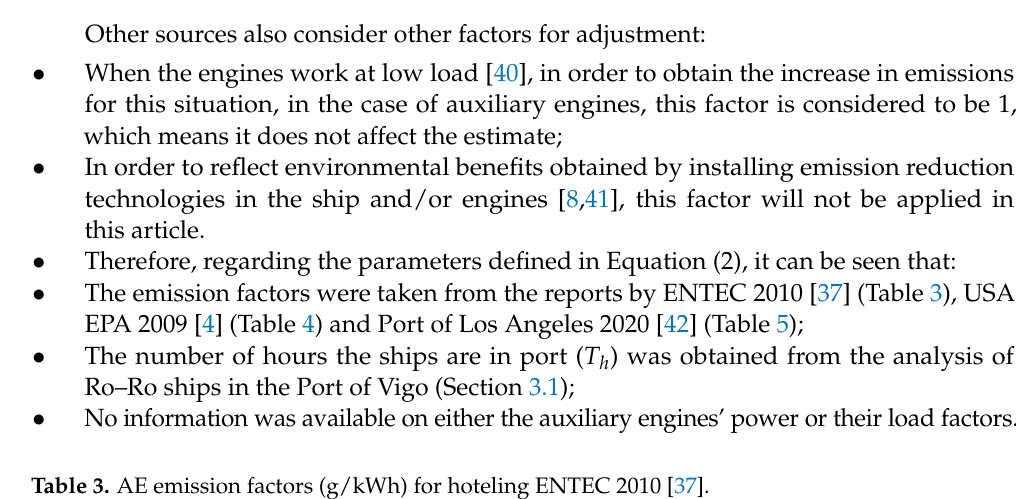
Table 3. AE emission factors (g/kWh) for hoteling ENTEC 2010 [37].